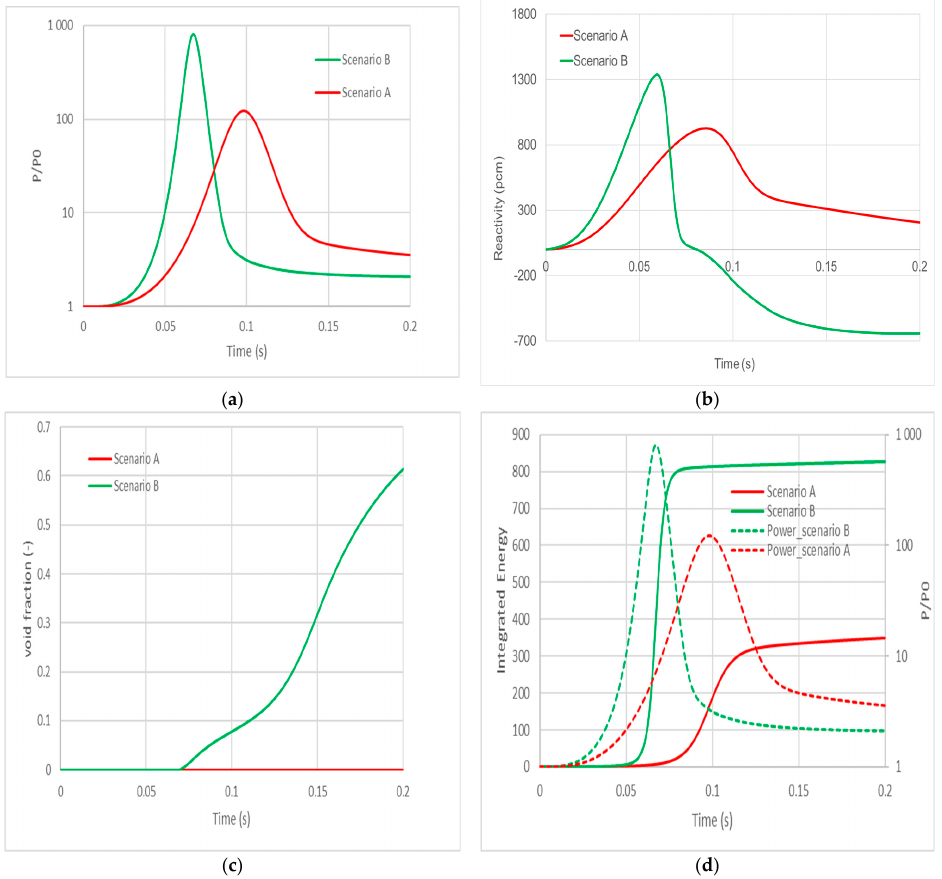
Figure 19. Scenarios comparison based on APOLLO3 ® /THEDI calculations: ( a ) power; ( b ) reactivity; ( c ) void fraction; ( d ) integrated energy.